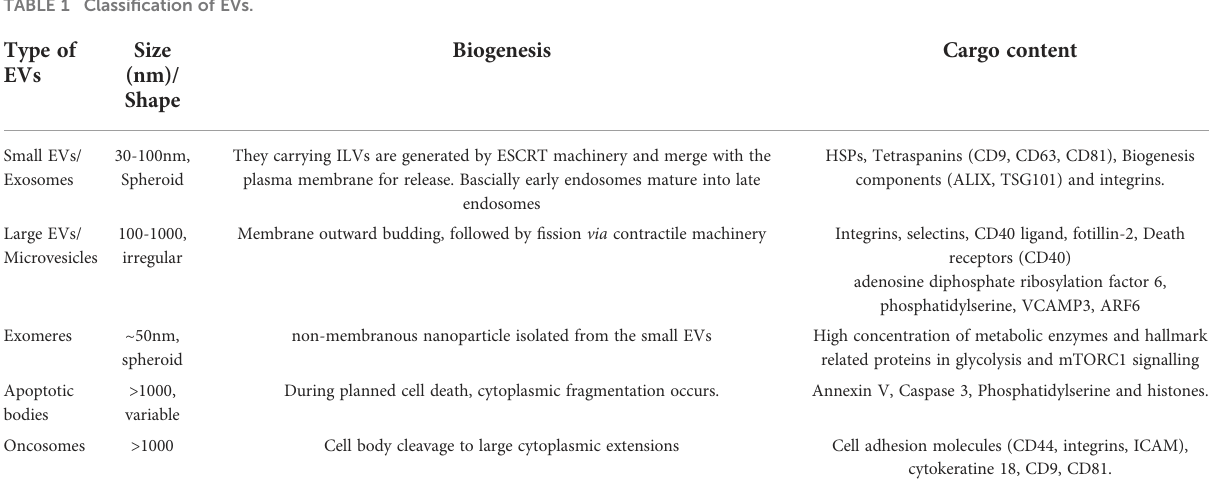
TABLE 1 Classi fi cation of